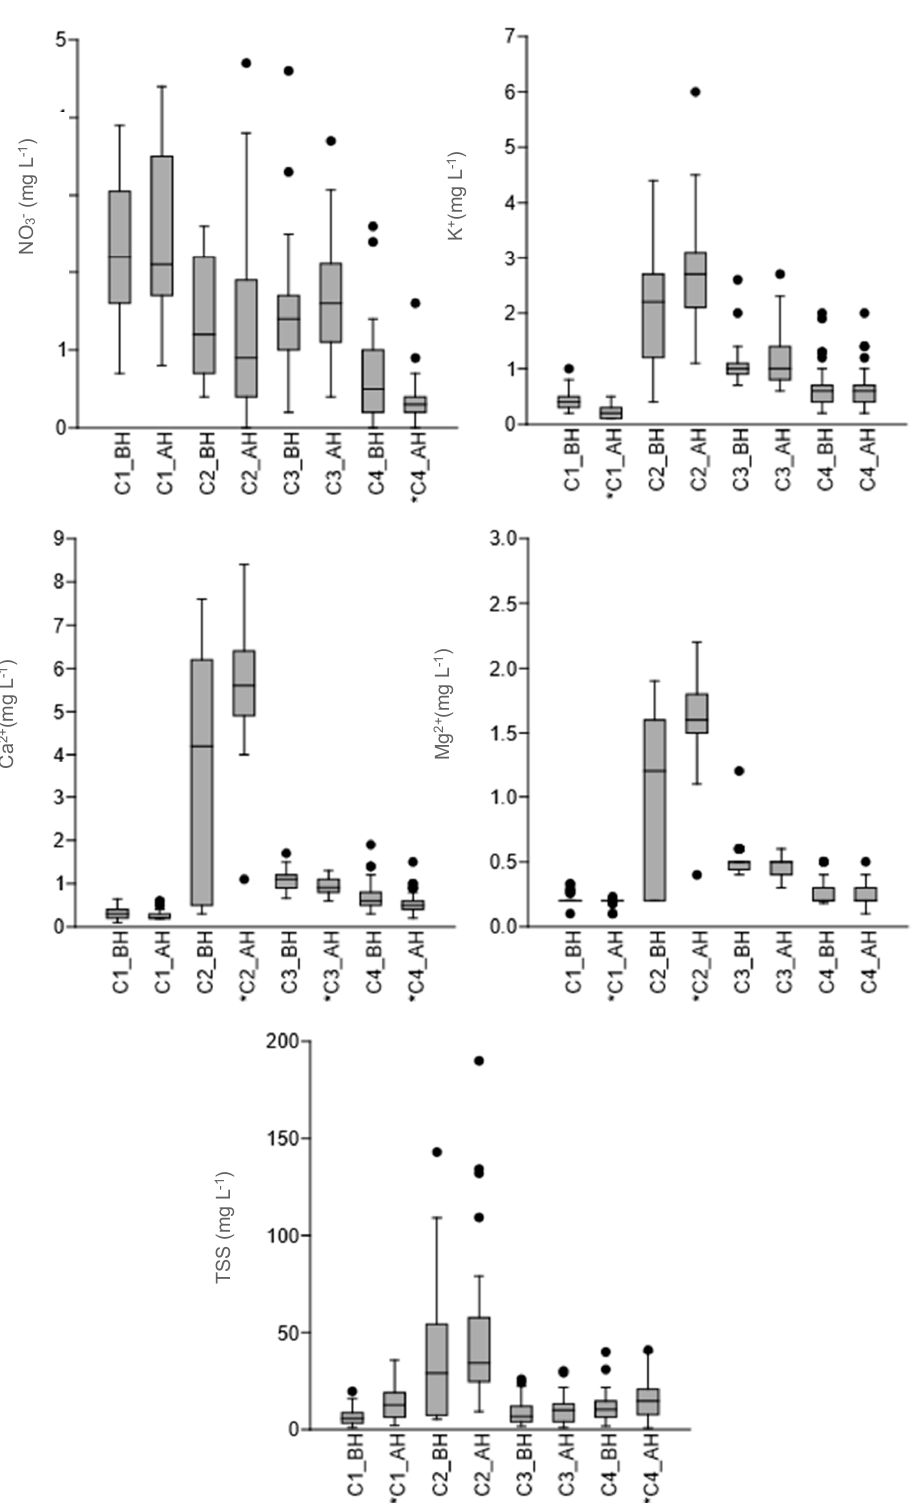
Figure 2. Concentration (mg L − 1 ) of nitrate (NO 3 − ), potassium (K + ), calcium (Ca 2 + ), magnesium (Mg 2 + ) and total suspended solids (TSS) obtained one year before (BH) and one year after (AH) harvesting in catchments C1, C2, C3, and C4. * denote statistically significant di ff erences between BH and AH years according to the Mann–Whitney test ( p < 0.05). Outliers are represented by black